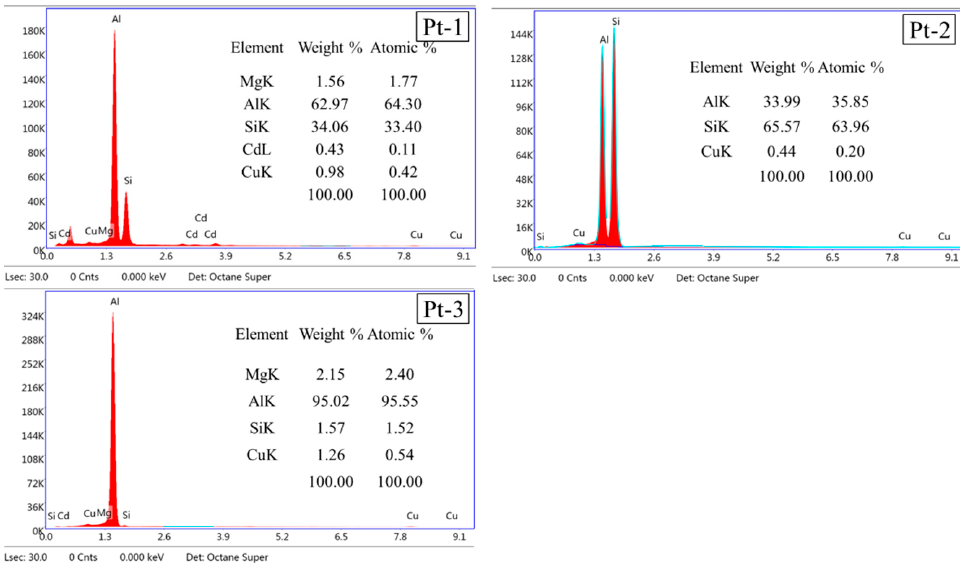
Figure 10. Characteristic SEM image, compositional mapping, and compositional point: ( a ) two-stage cadmium containing alloys and ( b ) three-stage cadmium containing alloys.